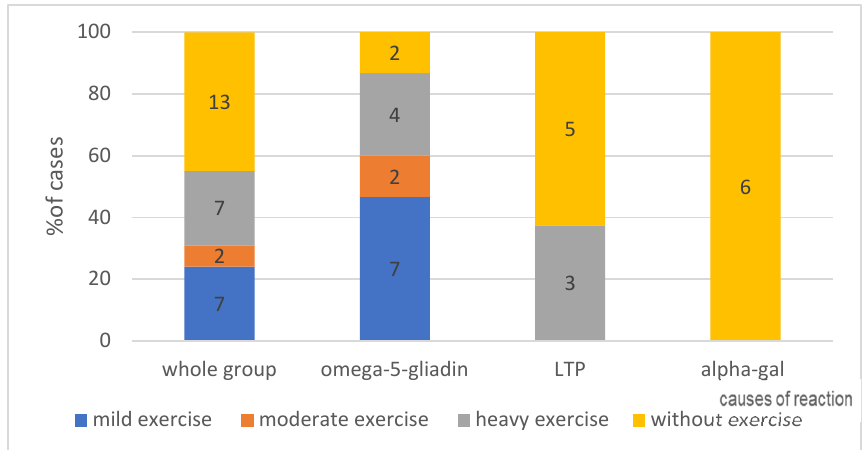
Figure 5. The exercise and intensity of exercise in analysed group, with division into individual causes. Absolute values of numbers of patients are given in the diagram.